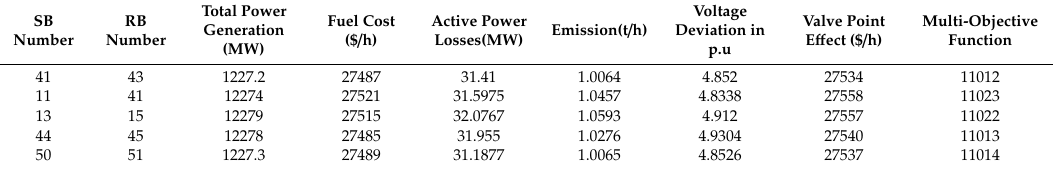
Table 4. Multi-objective function in IEEE 57 bus system by locating TCSC in di ff